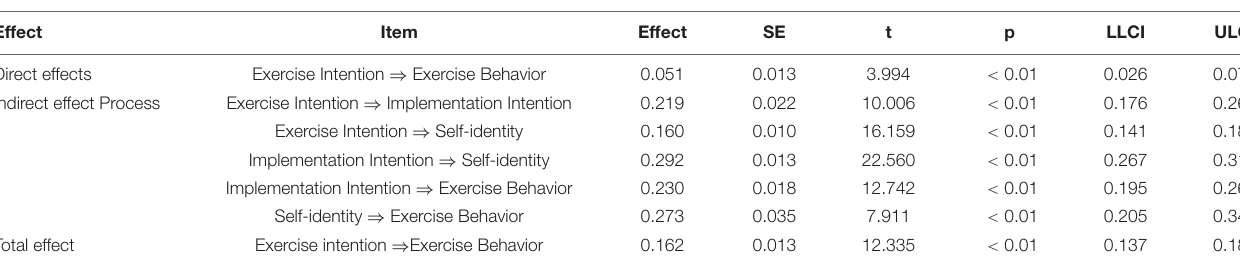
TABLE 4 | Analysis of regression relationship of